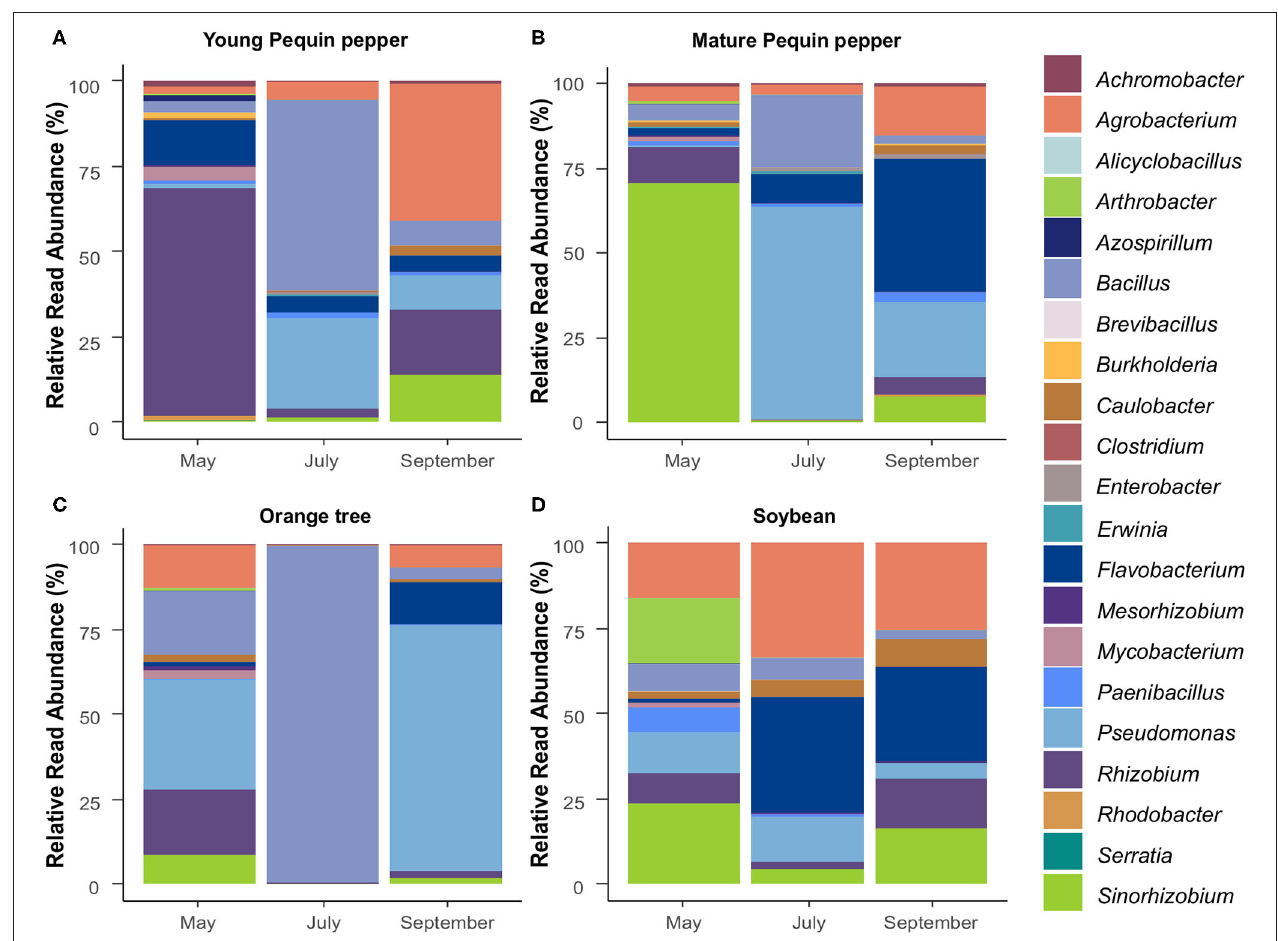
FIGURE 6 | Genera composition of growth promoting rhizobacteria (PGPR) for young (A) and mature (B) Pequin pepper, orange tree (C) , and soybean (D)